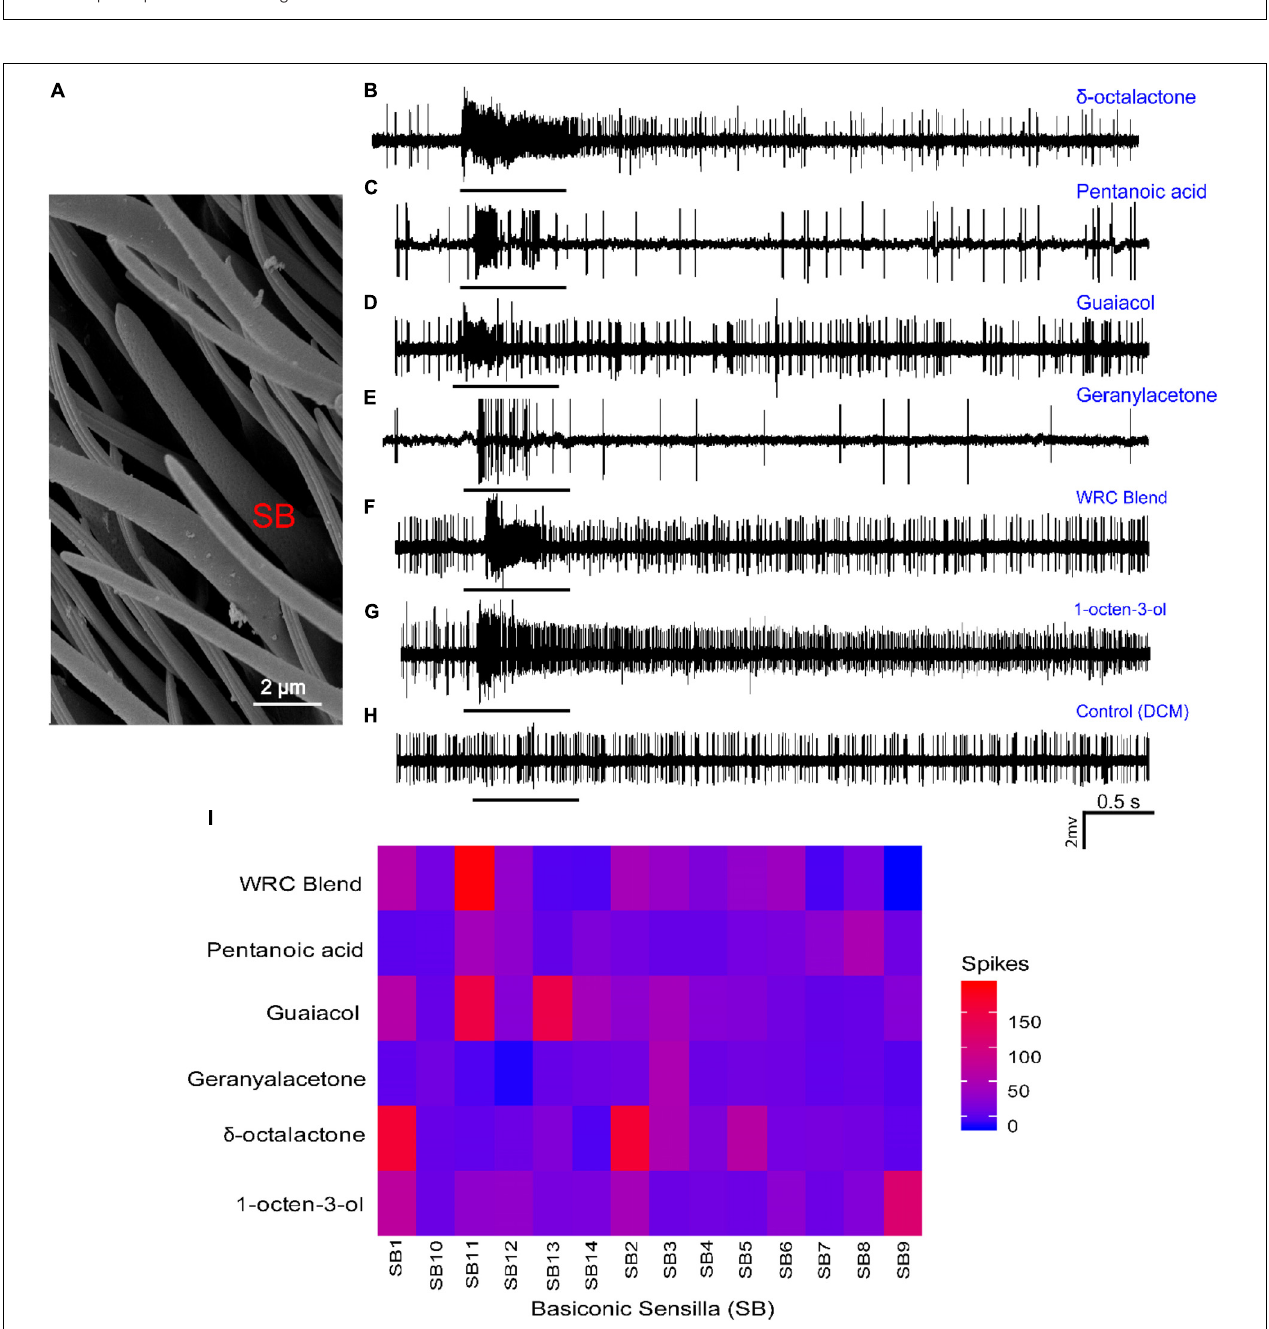
FIGURE 7 | Bioinformatics analysis for the interaction of the different ligands with their putative odorant receptors. Amino acid residues in interaction within 5 Å of ligands as depicted by the ligand interaction diagram for pairs (A) Geranyl acetone-GffOr2a2, (B) δ -octalactone_GffOr24b, (C) δ -octalactone-GffOr85b, (D) pentanoic acid-GffOr45a2, (E) Guaiacol-GffOr46a2, and (F) 1-octen-3-ol-GffOr13a. Generated using ICM-Pro software (Ruben Abagyan, 1994) (version 3.8-7, MolSoft LCC, San Diego, CA, United States, www.molsoft.com). Green shading represents the hydrophobic region; white dashed arrows represent hydrogen bonds; gray parabolas represent accessible surface for large areas. The broken thick line around the ligand shape indicates an accessible surface. The size of the residue ellipse represents the strength of the contact.